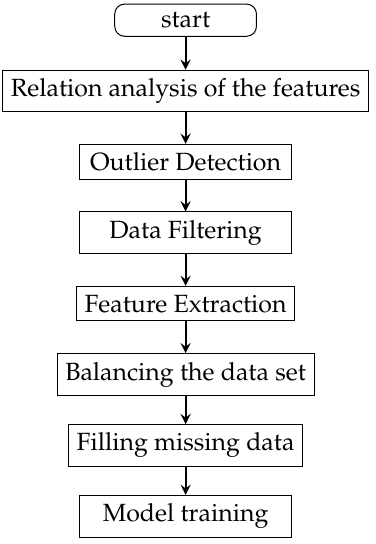
Figure 2. The data processing flow path.